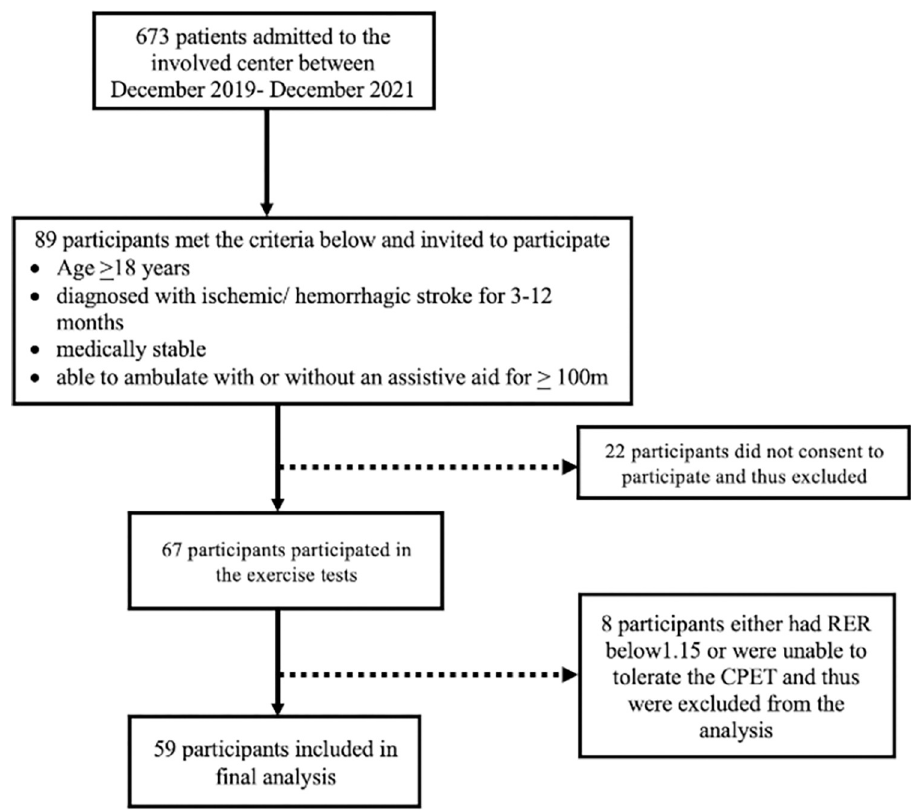
Fig 1. A flow chart illustrating the number of patients entered for final